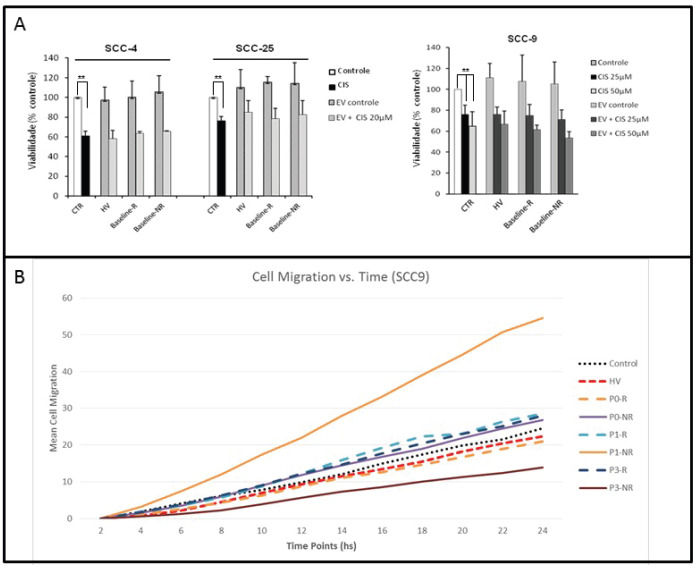
Functional assays using EVs. (a): Cisplatin IC50 was determined for three HNSCC cell lines (SCC-4, SCC-25 and SCC-9). Control samples had a statistically significant decrease in cell viability with cisplatin in 3-(4,5-Dimethylthiazol-2-yl)-2,5-diphenyltetrazolium bromidefor (MTT) assays. The addition of HV, responders and non-responders EVs did not alter significantly cisplatin cell sensitivity. Values are means ± SD of three separate experiments. (b): Scratch migration assay with SCC-9. Assays with EV from HV, responders at P0, P1 and P3 (hashed lines) and non-responders at P0, P1 and P3 (straight lines) were compared to controls. EV from non-responders led to a significant increase in SCC-9 migration rate compared to control (p < 0.001). Values are means ± SD of at least two separate experiments.